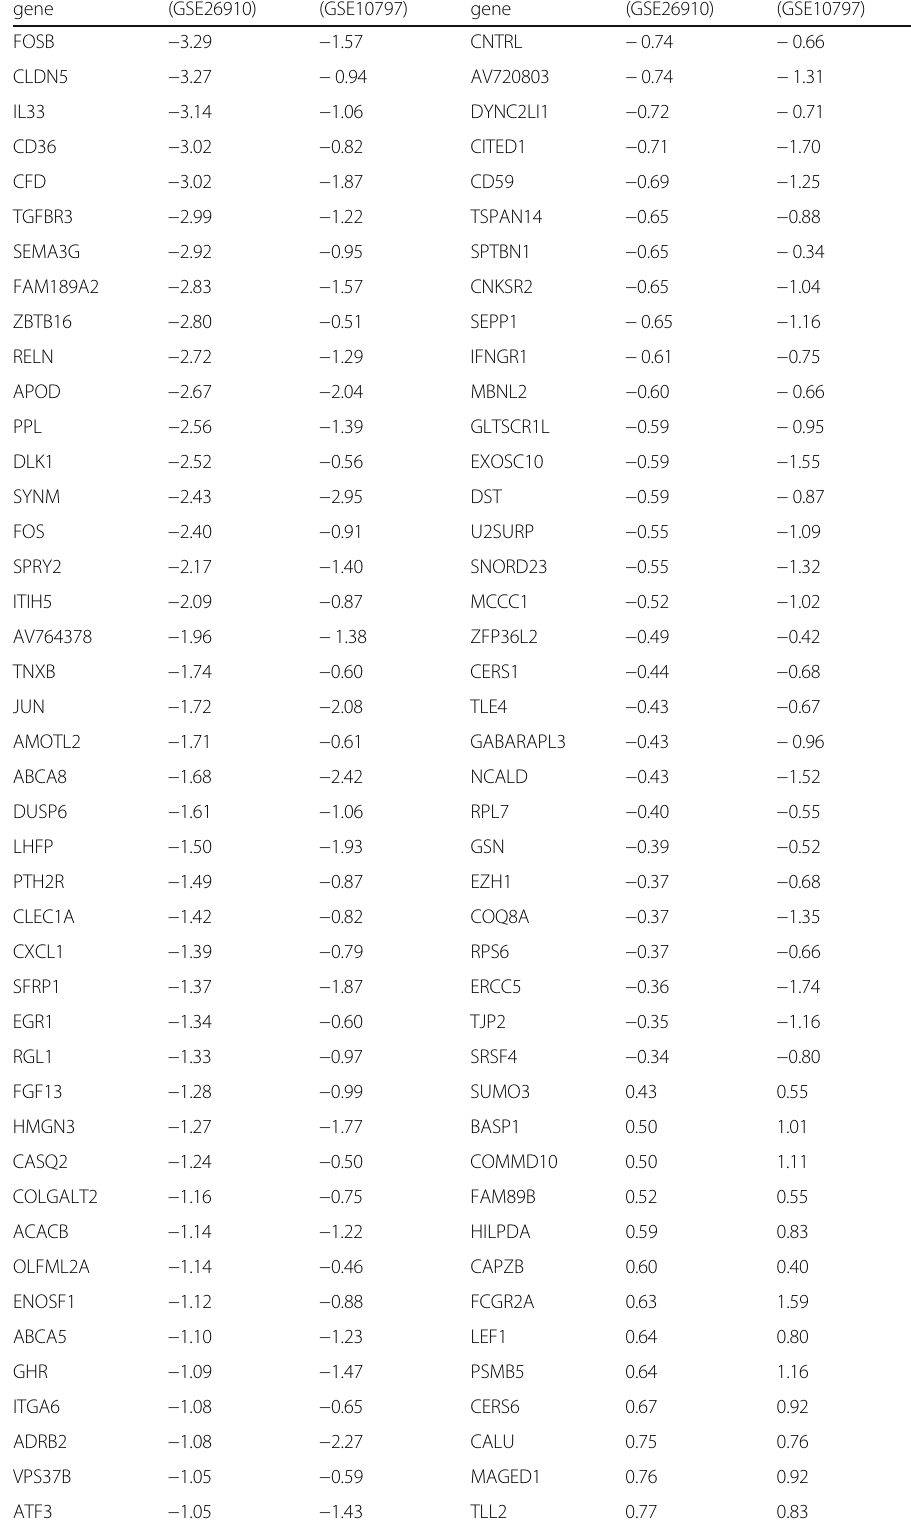
Table 1 The common genes altered in both the GSE26910 and GSE10797 datasets Overlapping